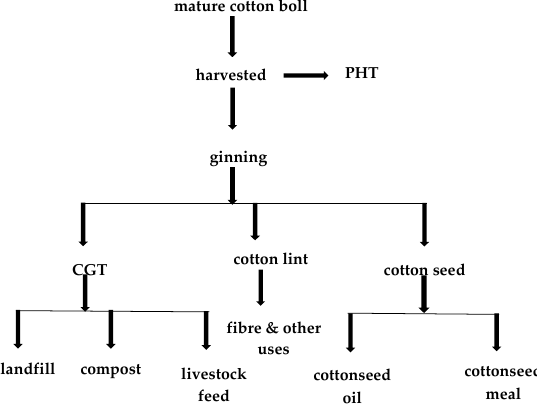
Figure 1. Flowchart of cotton processing from field to cotton gin products.